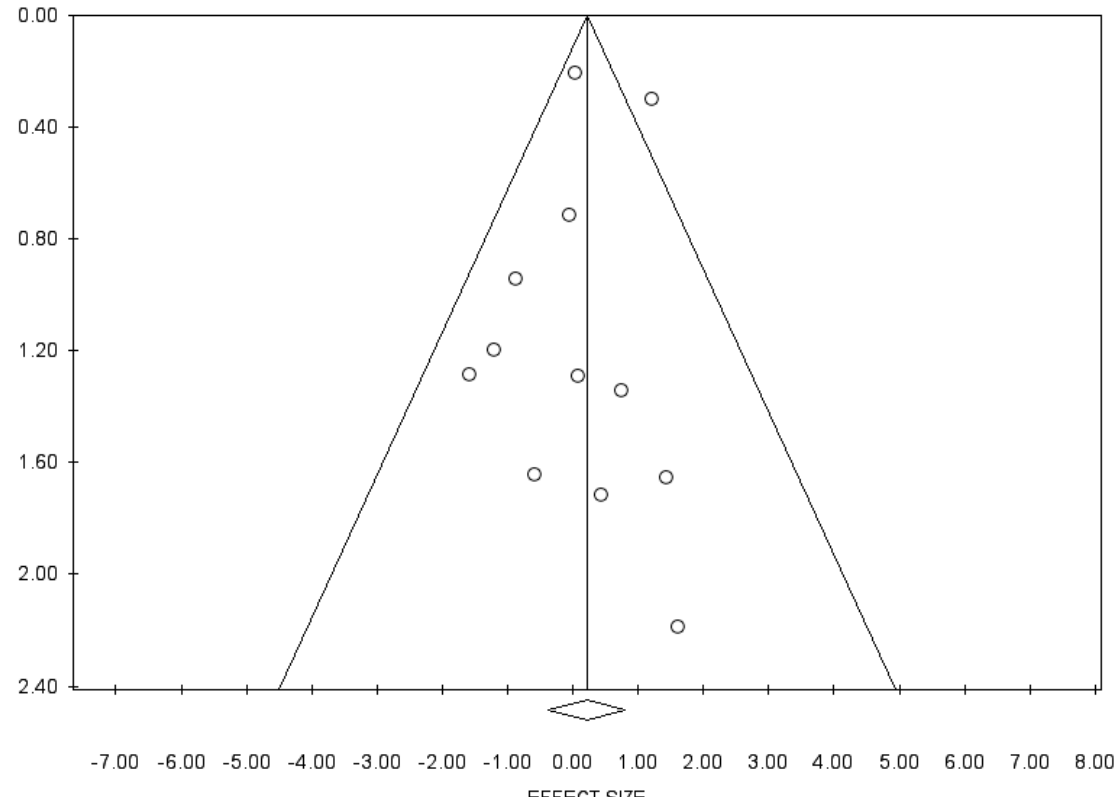
Figure 3. This funnel plot shows the process of detecting publication bias.